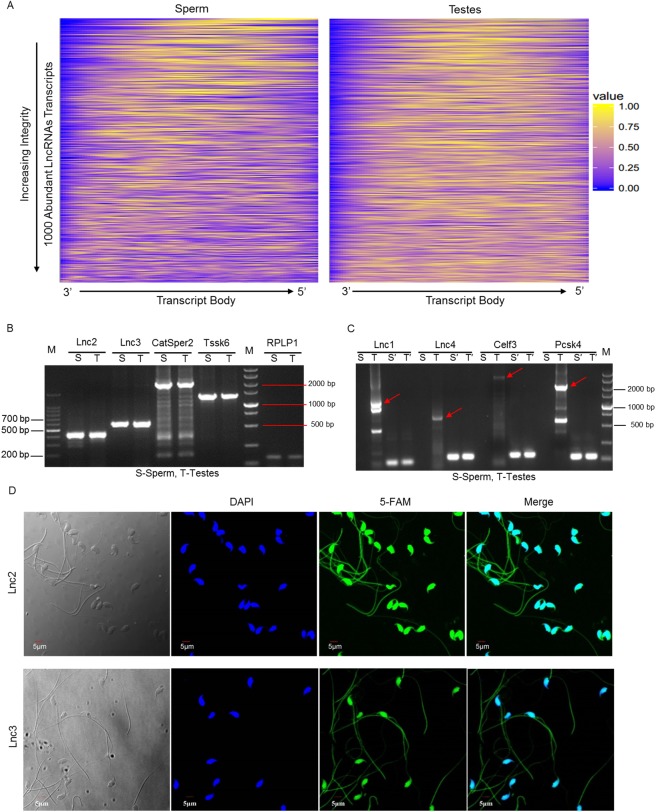
Integrity evaluation and existing forms of sperm lncRNAs.(A) Integrity evaluation of sperm lncRNAs using a computational approach. To determine the uniformity of coverage for each, RNA transcripts were divided into 100 bins, and a 5-bin moving average was used to calculate localized variations in sequencing coverage. The squared deviation from expected coverage for each bin was summed and used as an intactness score to rank the 1000 lncRNAs according to their stability. (B) Intact RNAs are present in sperm; the testes served as positive control to amplify the proposed full-length mRNAs and lncRNAs. (C) The fragmented RNAs degraded or cleaved from the intact transcripts were amplified in sperm. S′ and T′: Representative fragments were amplified from sperm and testes cDNA, respectively. (D) The localization of two representatively intact lncRNAs with FISH staining.